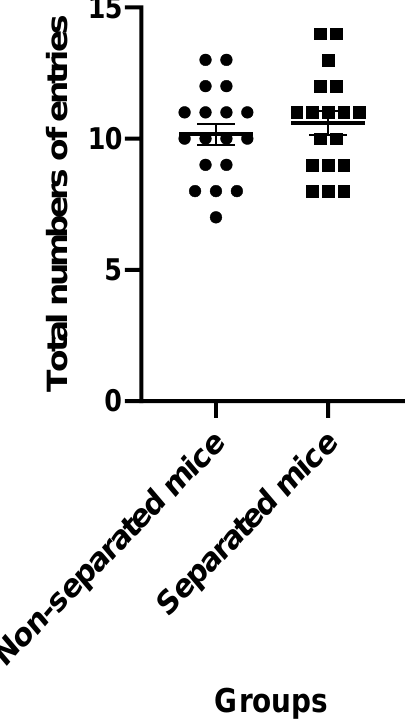
Figure 3. Time spent in the open arms. (*) indicates significant difference ( p < 0.05) between sepa- rated and non-separated mice by the unpaired t test ( n = 18/each group).